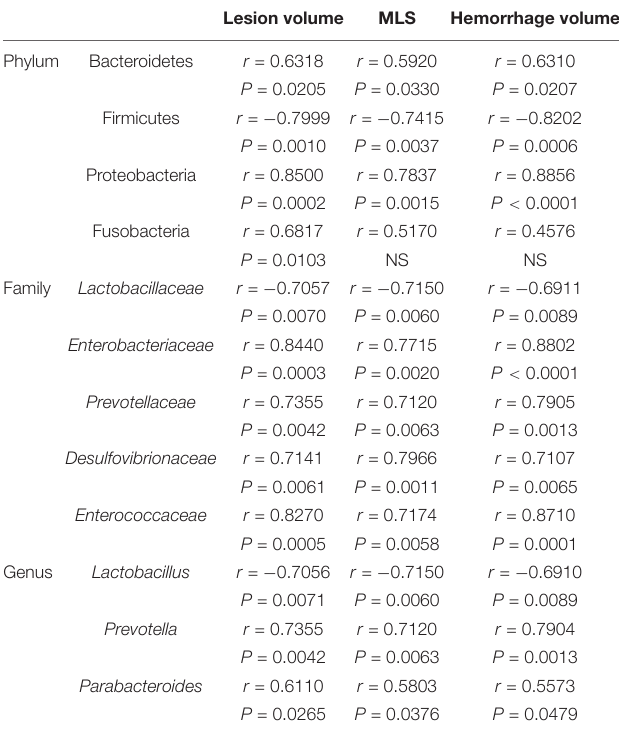
TABLE 2 | Changes in gut microbiota composition for 3 days poststroke were correlated with lesion volume, midline shift, and hemorrhage volume in ischemic stroke in a pig model ( n =